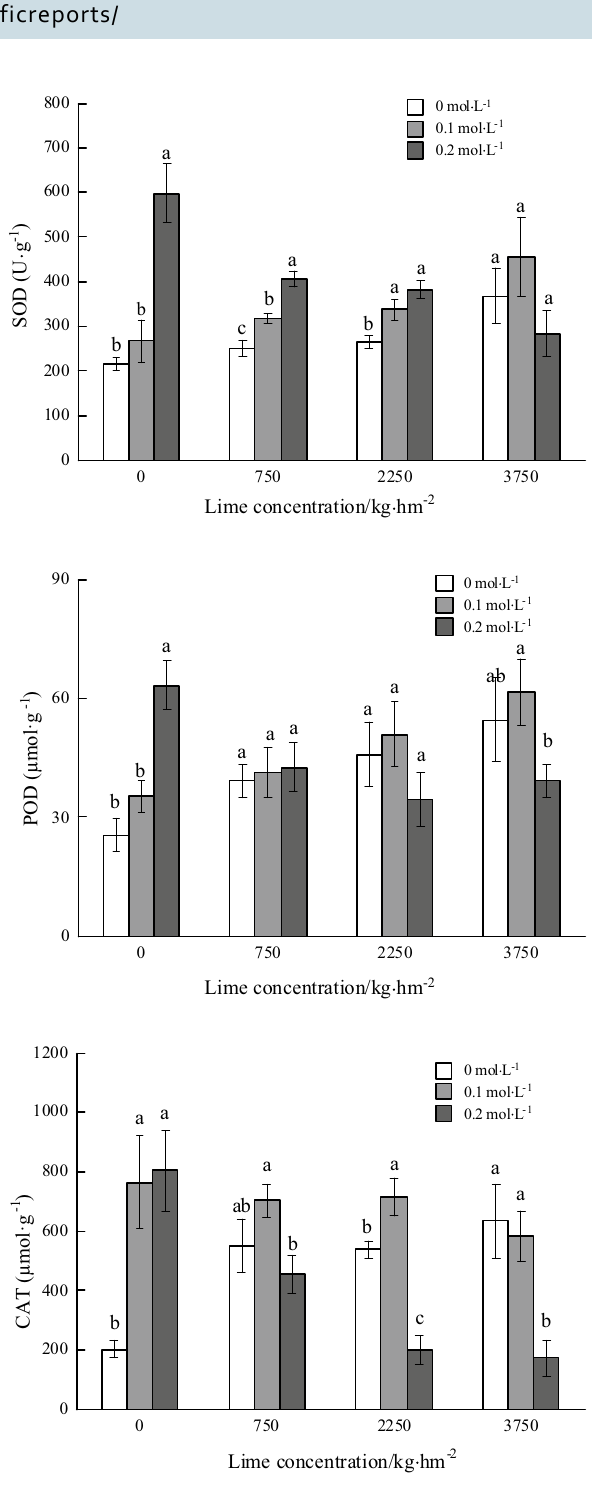
Figure 2. Effects of foliar spraying of oxalic acid on activities of superoxide dismutase, peroxidase and catalase in roots of Panax notoginseng under Cd